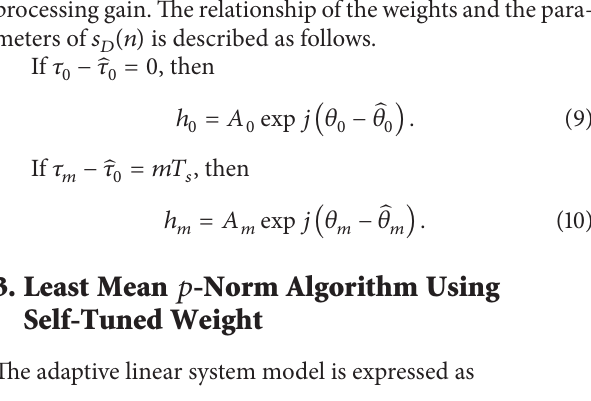
Figure 3: Proposed weight updating